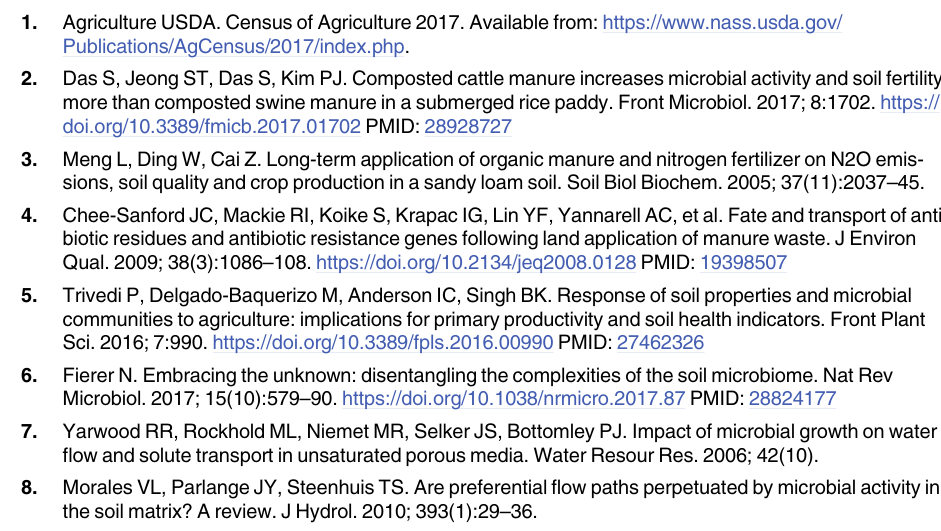
S1 Table. Relative abundance of manure associated OTUs.